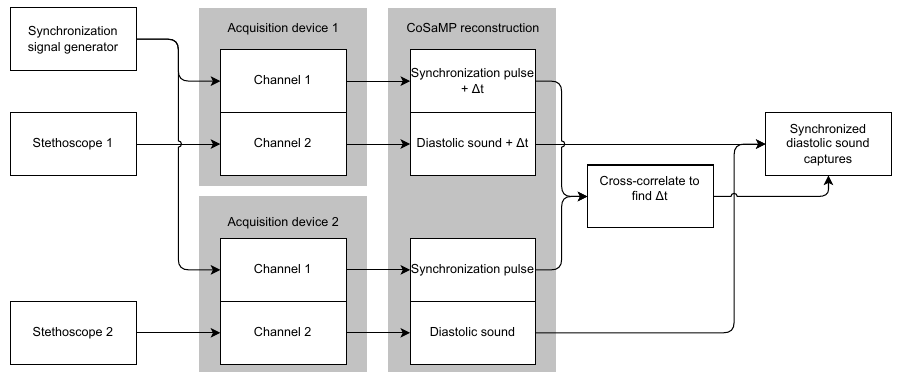
Figure 5. Setup for the demonstration of the proposed synchronization approach using a pseudo- random block pulse generated using a signal